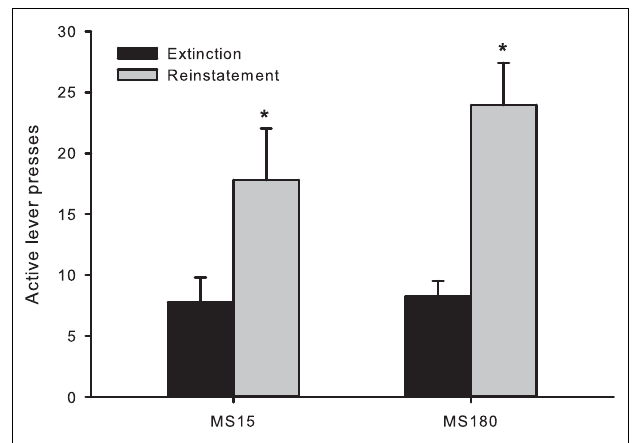
FIGURE 4 | Number of active lever presses across the final 2days of extinction training and during cue-induced reinstatement in MS15 ( n = 9) and MS180 ( n = 17) rats . Data points represent group mean ± SEM. * p < 0.05 vs. extinction.